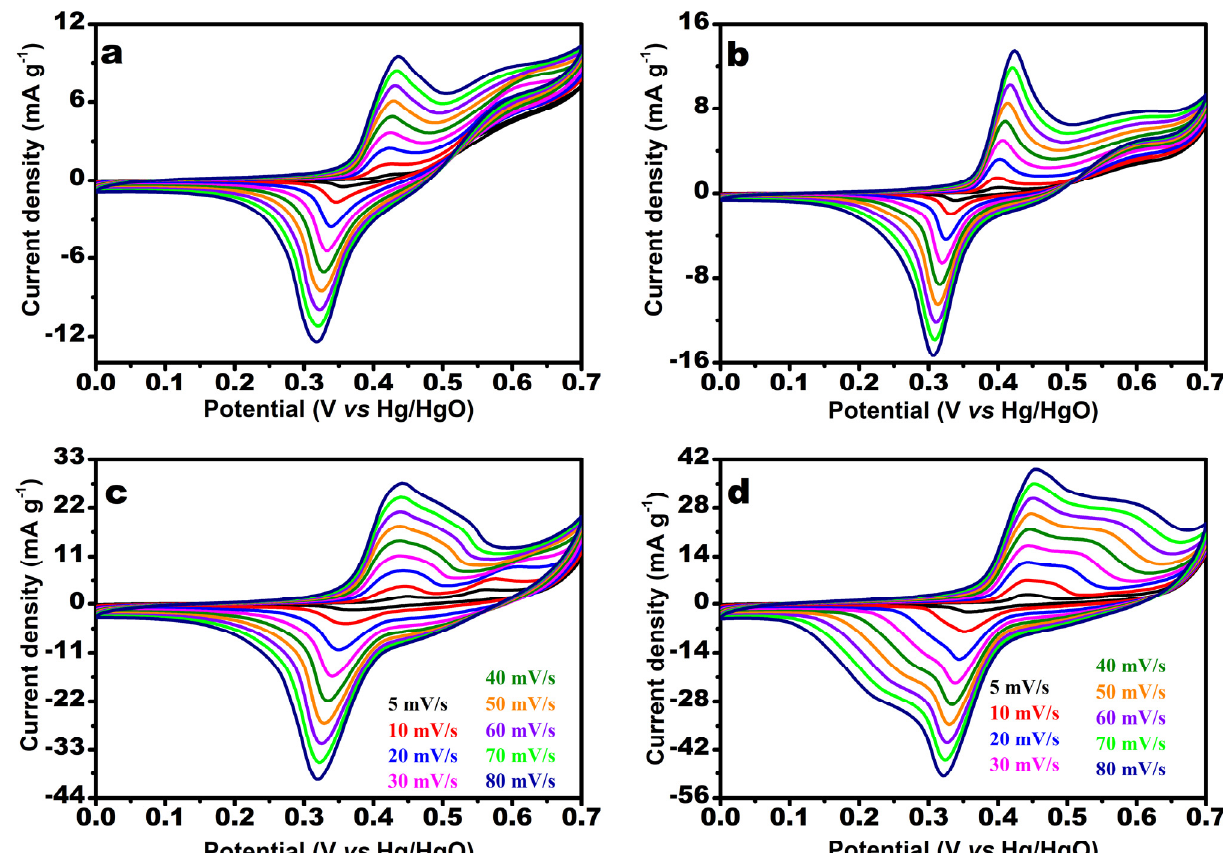
Figure 6. CV curves of the electrocatalysts at various scan rates; MW-7 ( a ), MW-12 ( b ), MW@GO-7 ( c ), and MW@GO-12 ( d ).